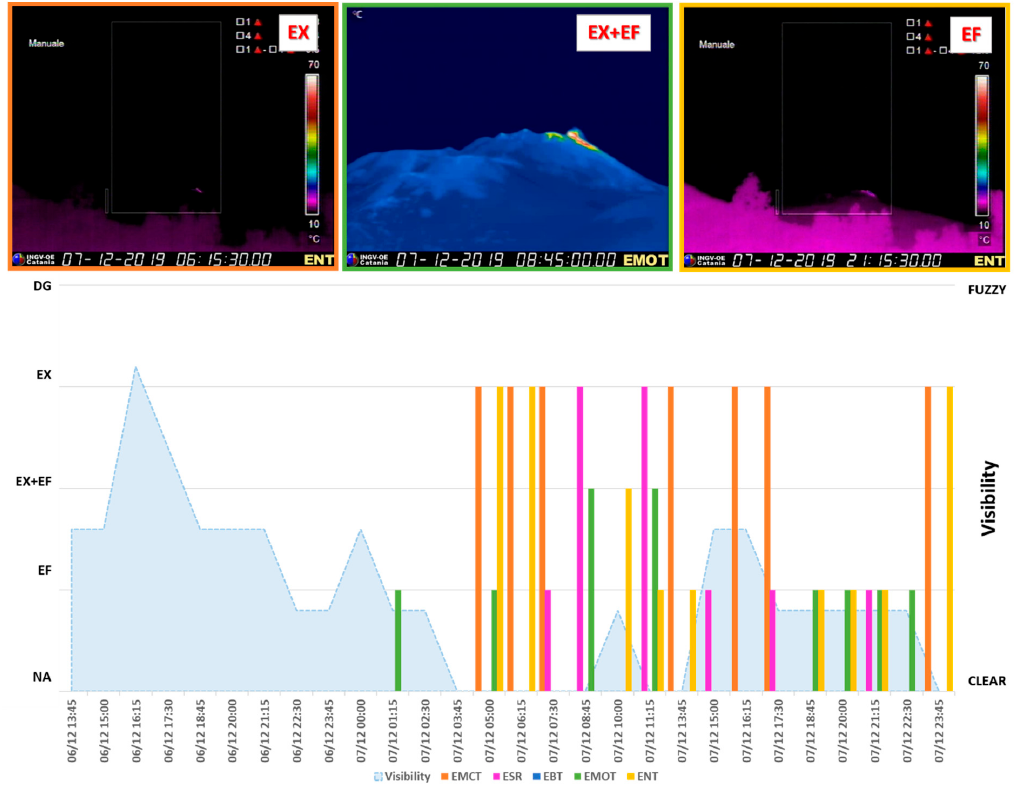
Figure 9. Volcanic activity evolution detected by the ML algorithm from 6 to 7 December, 2019. “DG”, “EX”, “EX + EF”, “EF” and “NA” stand for degassing, explosive, explosive and e ff usive, e ff usive